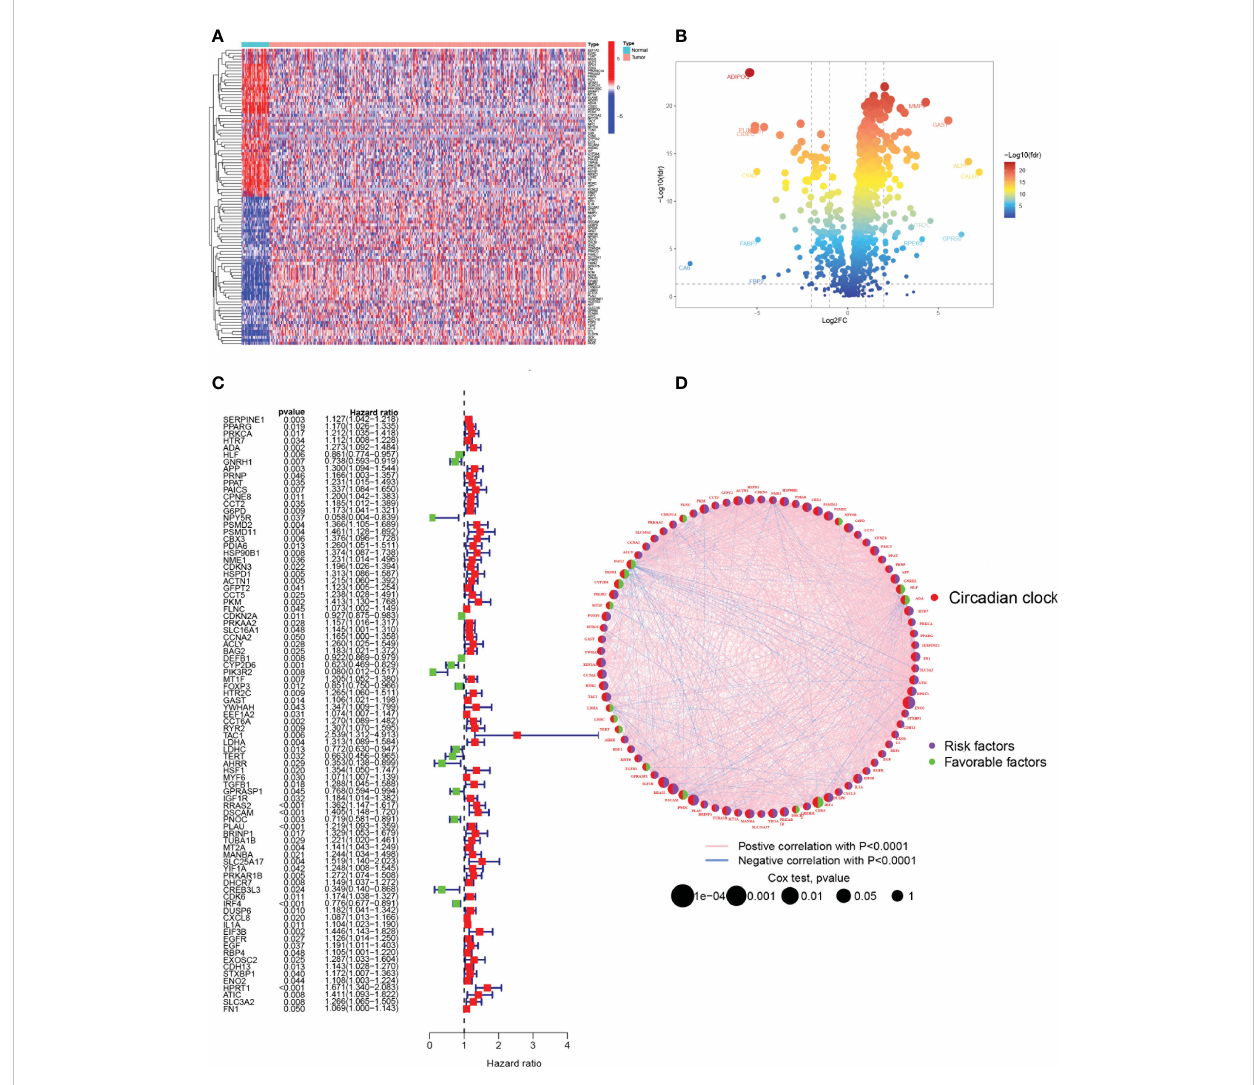
FIGURE 2 Identi fi cation of candidate CRRGs. (A, B) Heat map and volcano plot of differentially expressed CRRGs. (C) The prognosis of 85 CRRGs in the whole HNSCC cohort was analyzed by a univariate Cox regression model. (D) Correlation analysis of the expression of CRRGs after 87 COX regression analyses. The genes with favorable prognoses are marked in green and the harmful factors in purple. The size of the point indicates the P -value calculated by the COX regression, the larger the value, the smaller the